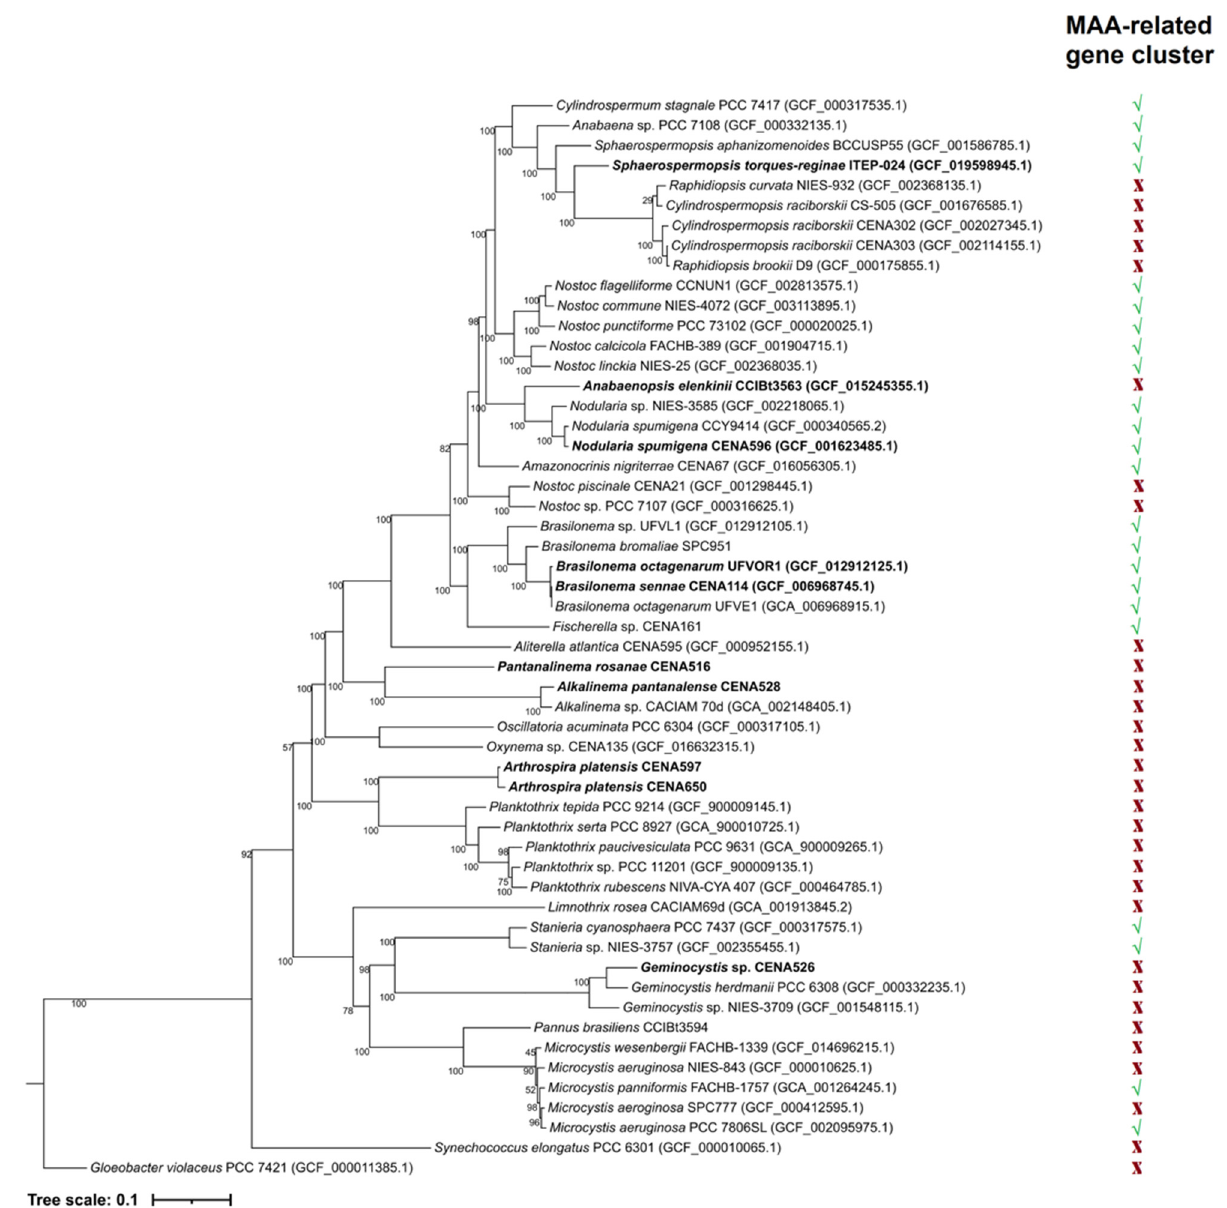
Figure 2. Maximum likelihood phylogenetic tree based on 120 cyanobacterial single-copy conserved markers displaying the relationship of the studied strains (in bold) with other cyanobacterial genomes. In the right parallel column, ( √ ) indicates the presence and (X) indicates the absence of the MAA-related gene cluster for each strain.